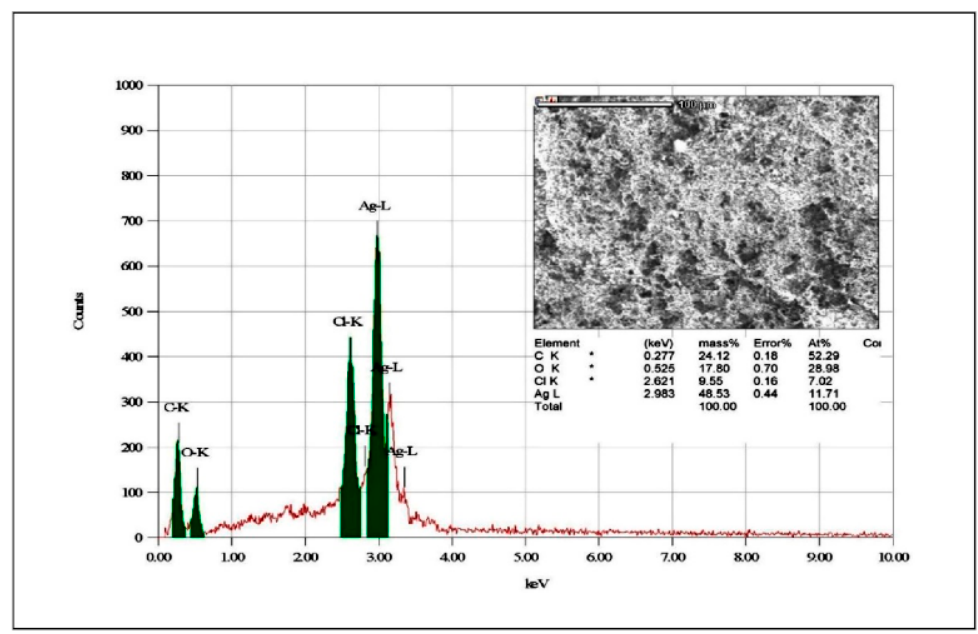
Figure 11. EDS spectrum for elemental analysis in Ag-NPs synthetized through Urtica diocia Leaves. Retrieved from an open source article [138].